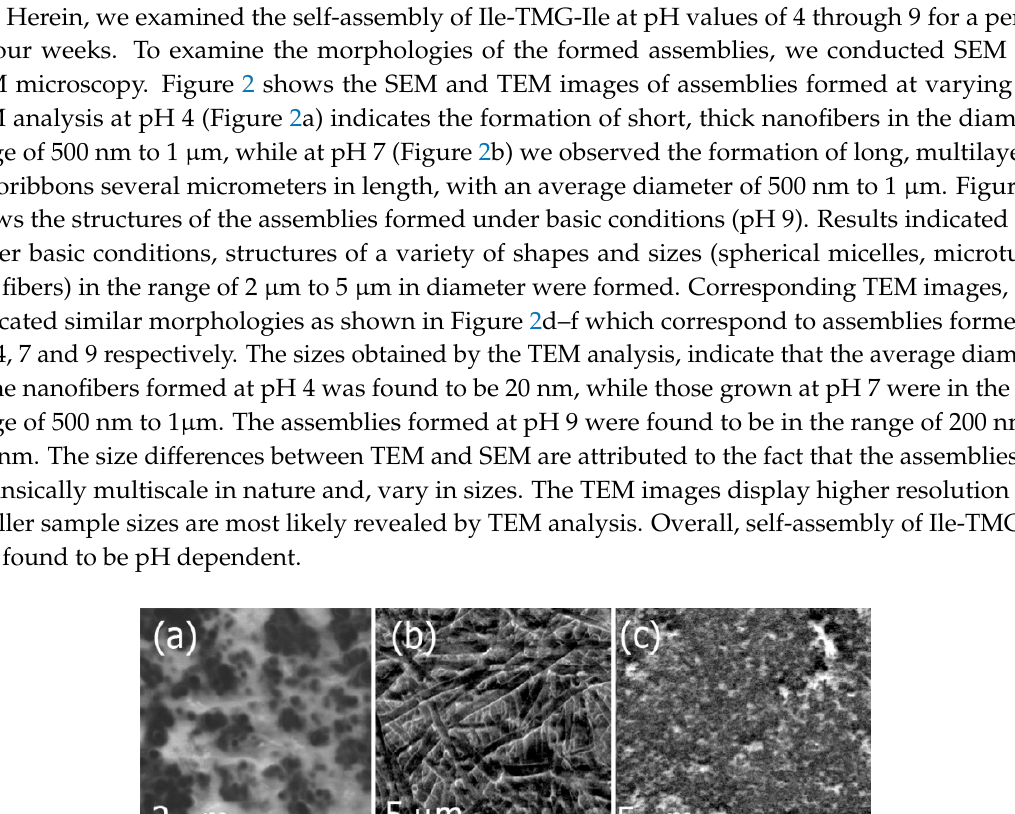
Figure 1. ( a ) Chemical structure of Ile-TMG-Ile; ( b ) ball and stick model.